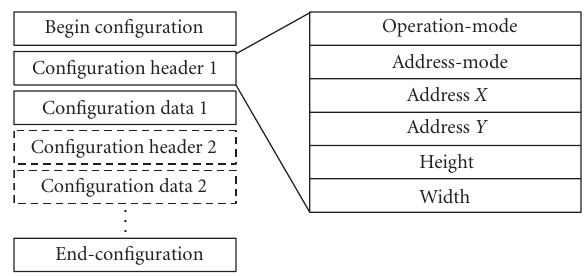
Figure 7: Configuration protocol.